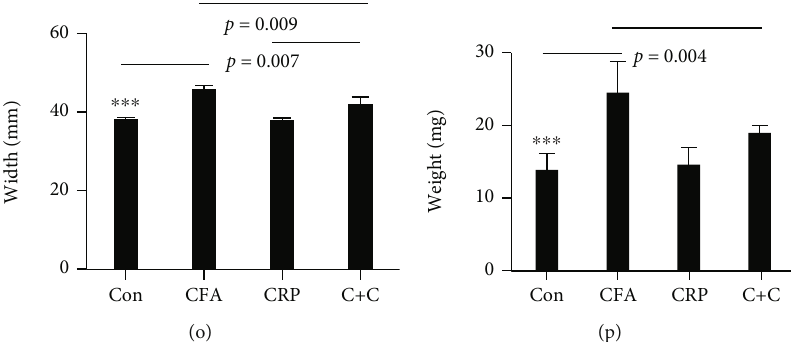
Figure 3: In fl ammatory manifestations in rat TMJs. (a) – (d) Representative images of rat heads with linear head width marked as the distance between the bilateral TMJs from Con, CFA, CRP, and C + C groups, respectively. (e) – (h) Representative images of exposed TMJs and synovial membranes from Con, CFA, CRP, and C + C groups, respectively. The part around with arrows is disc, and synovium covered with grey stars. Note swollen and hyperplastic synovial membranes in the CFA and C + C groups. (i) – (l) Representative images of discs from Con, CFA, CRP, and C + C groups, respectively; the thickened opaque discs from the CFA group were obvious. (m) and (n) Magni fi ed images of (j) and (l) showed central middle of disc, which should be transparent in normal (area around with arrows in (n)). Note that this area disappeared in the CFA group (m). (o) Di ff erent of head widths among groups. Note the width increase in C + C group is not that much in the CFA group compared to their corresponding control groups. (p) Net weights of the discs showing signi fi cantly higher weights in the in fl ammation groups than in the control groups ( N = 8 ; mean + SD ; ∗∗∗ p < 0 : 001 ); Con: control, C + C : CRP + CFA